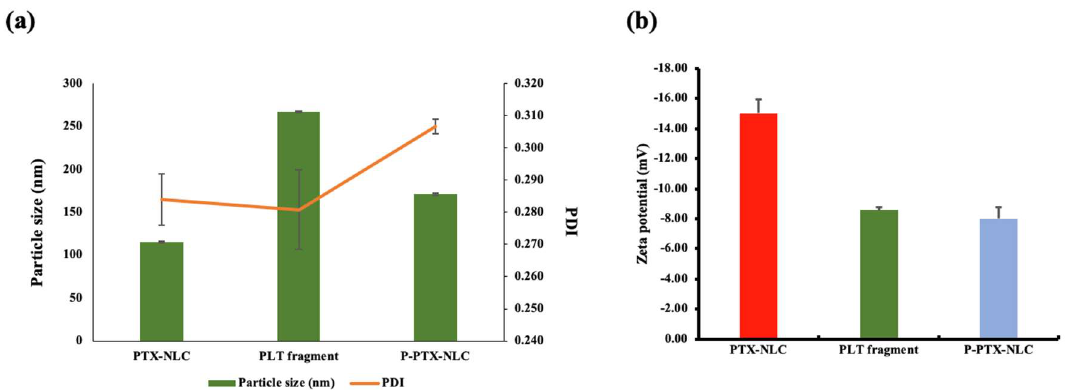
Figure 2. The physicochemical characterizations. ( a ), particle size and polydispersity index (PDI); ( b ), zeta potential of PT-NLC, PLT and P-PT-NLC ( n = 3, mean ± standard deviation (SD)).